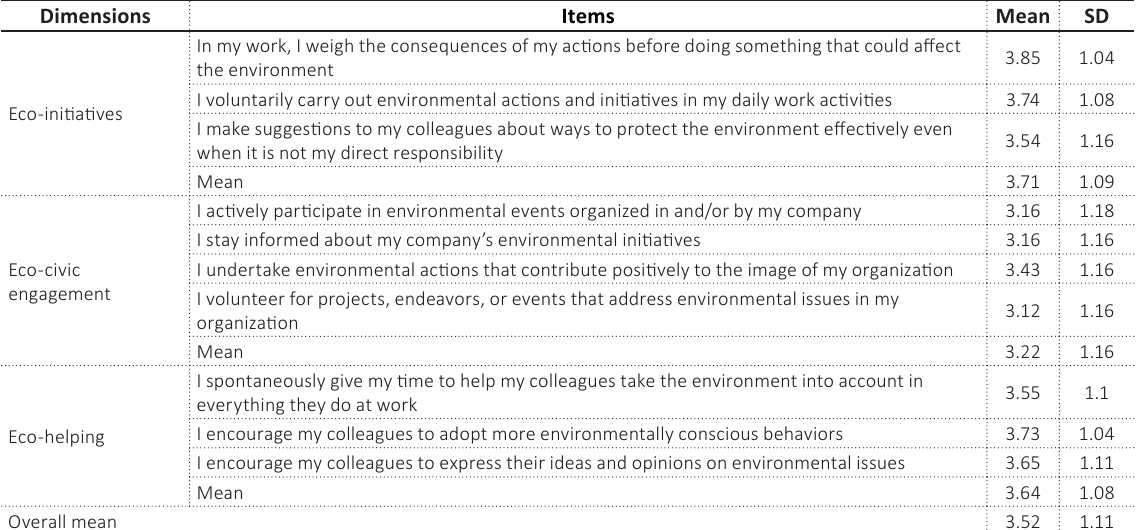
Table 2. Means (M) and standard deviation (SD) of environmental behavior Dimensions